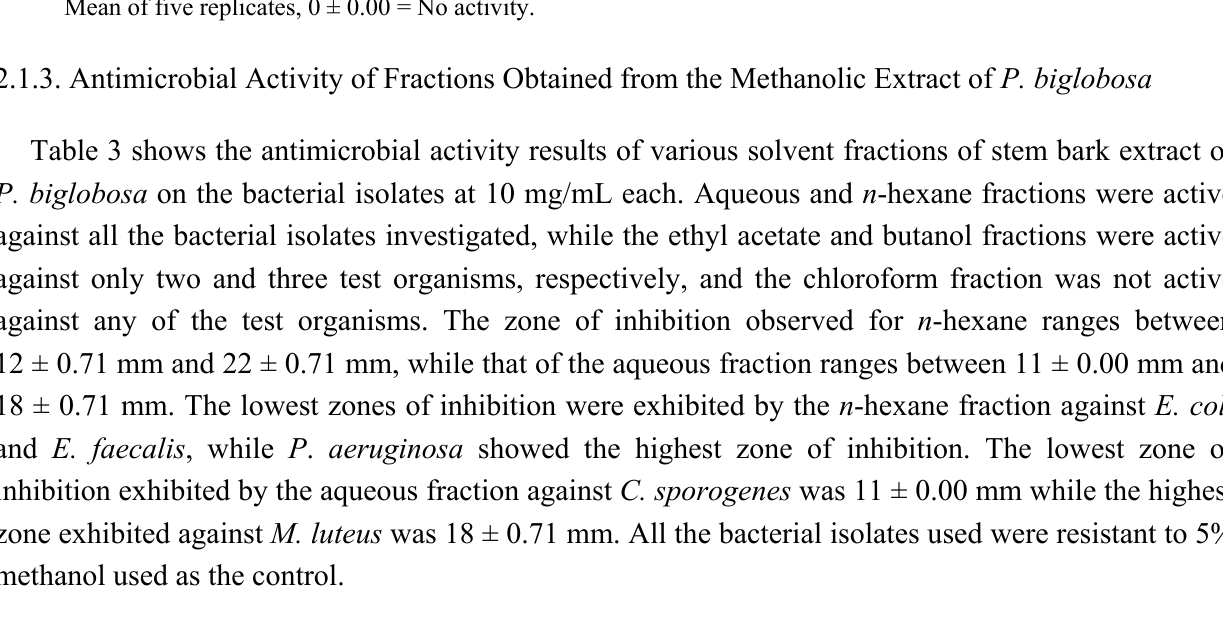
Table 3. Sensitivity testing of partitioned fractions of Parkia biglobosa stem bark extract on bacterial